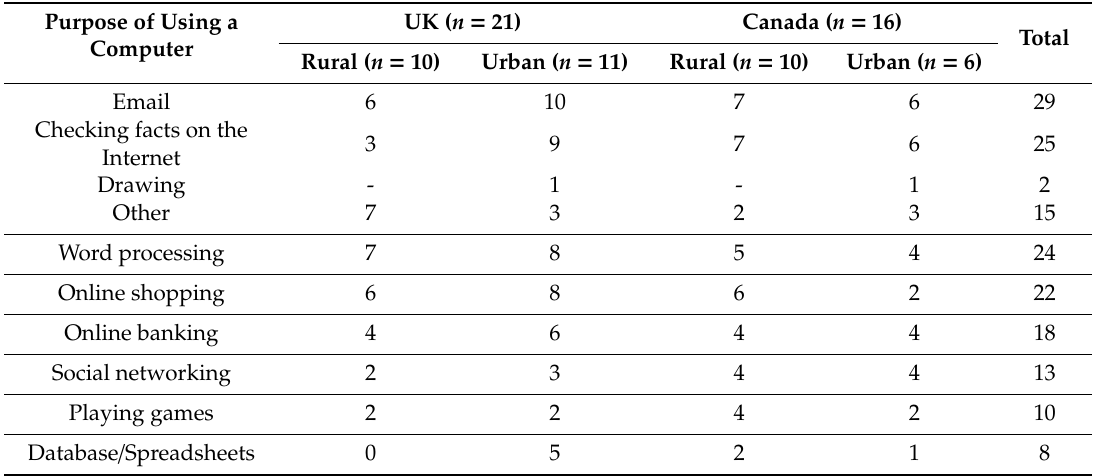
Table 3. Purpose for using a computer by country (UK and Canada) and location (rural and urban). Purpose of Using a